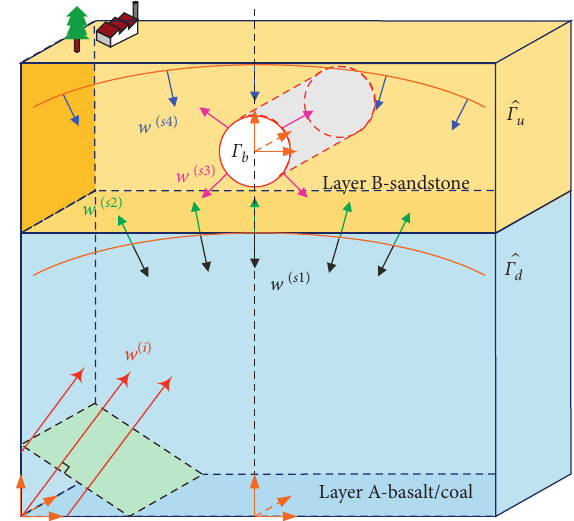
Figure 3: Scattered wave field in composite